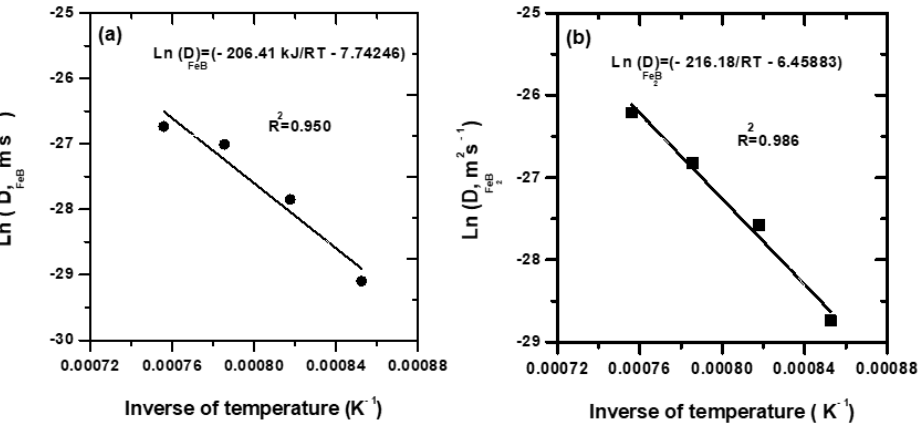
Figure 2. Computed boron diffusion coefficients in the FeB and Fe 2 B layers fitted with the Arrhenius equations ( a ): FeB and ( b ): Fe 2 B .